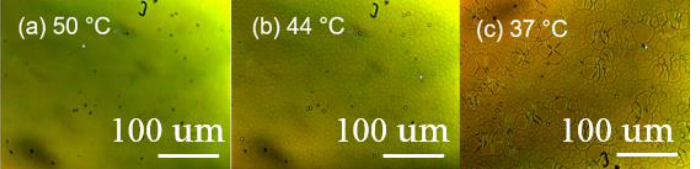
Figure 4. POM images of the PS-SPLC precursor with: ( a ) isotropic phase (50 °C); ( b ) sphere phase (44 °C ) ; ( c ) cholesteric phase (37 °C).